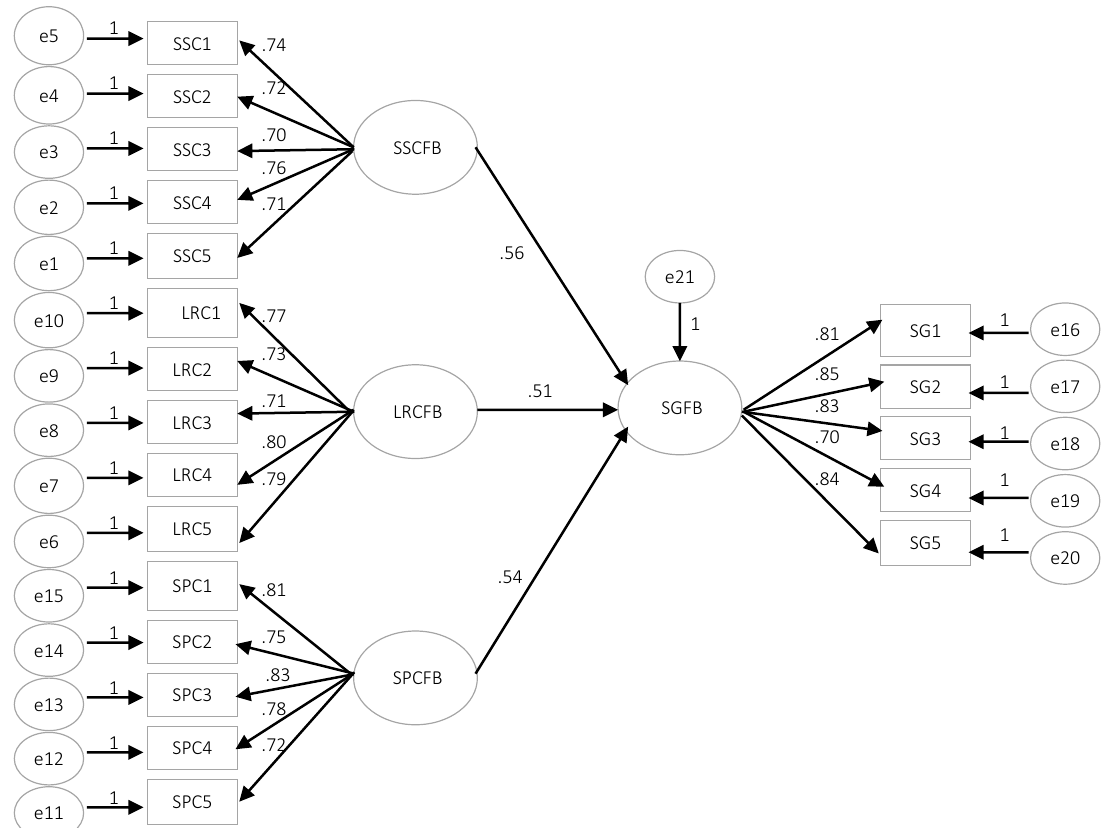
Figure 2. Structural path analysis of the study